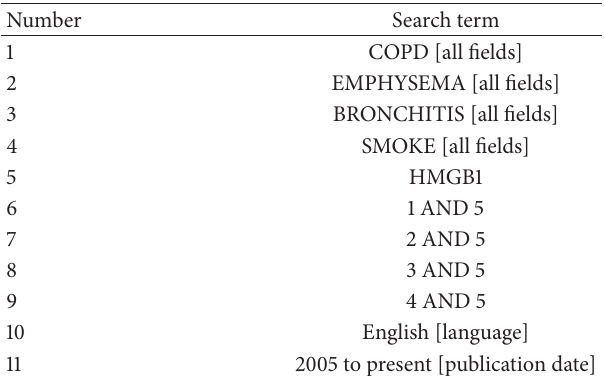
Table1:ListofsearchtermsenteredintothePubMedsearchengines for identification the studies for this systematic